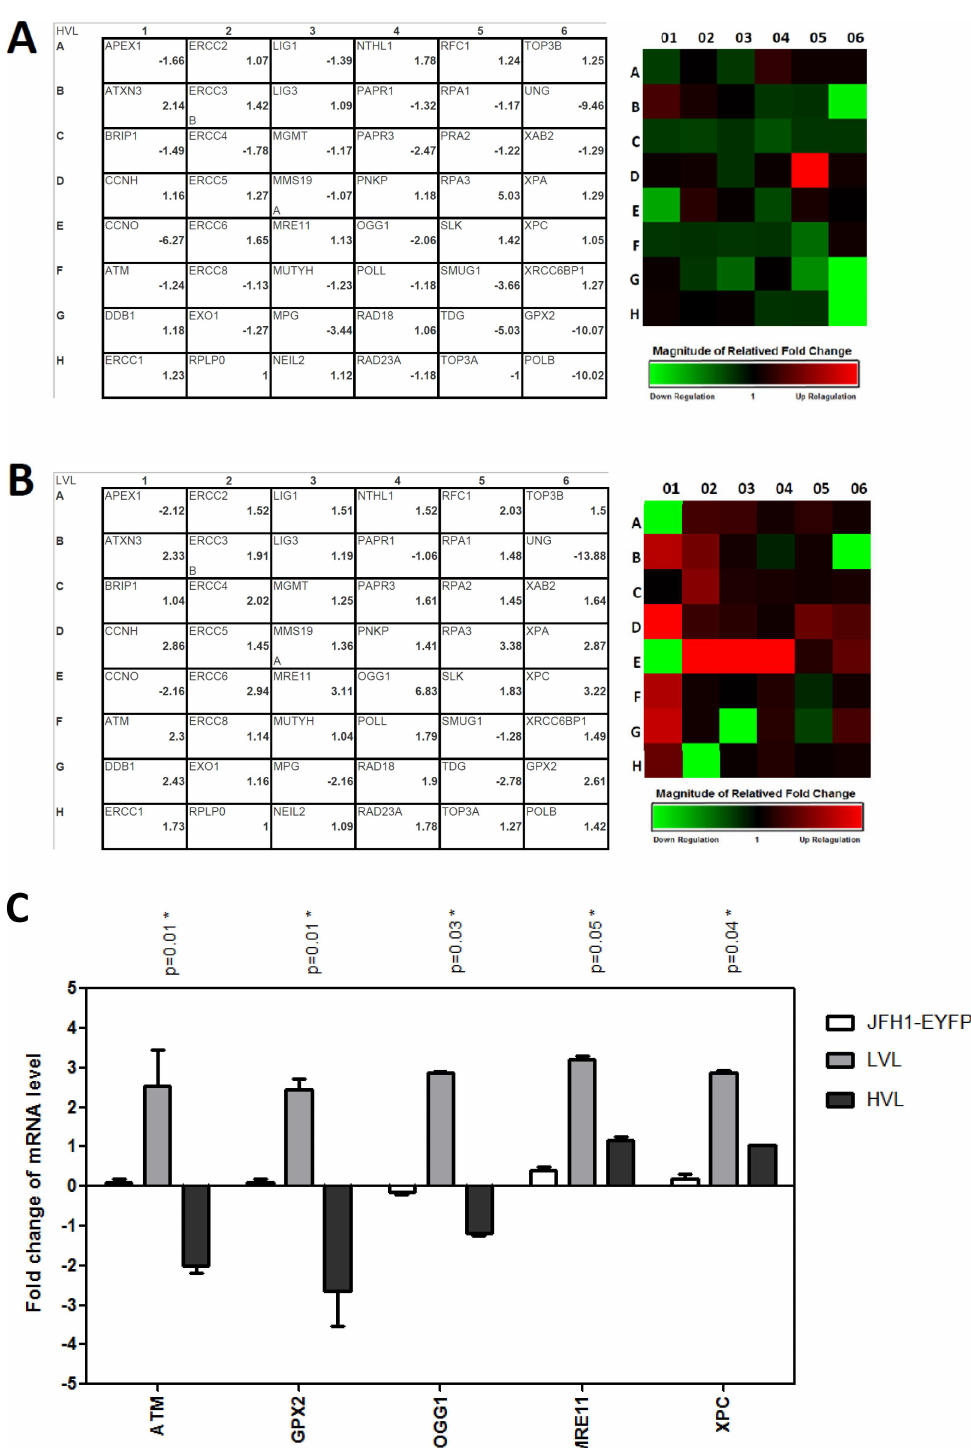
Fig 3. Different repair genes were identified in the HVL and LVL sorted cells. The 48 repair genes were analyzed,using a DNA Repair RT 2 Profiler PCR Array kit, in (A) HVL cells and (B) LVL cells. The data were normalizedto RPLP0 housekeeping gene levels and presented as the fold change. (C) The q-PCR of fold change expression of the ATM , ERCC6 , GPX2 , MRE11 , OGG1 and XPC mRNA levels in the HVL and LVL cells. Uninfected Huh7.5.1 cells served as the control group. * P < 0.05.